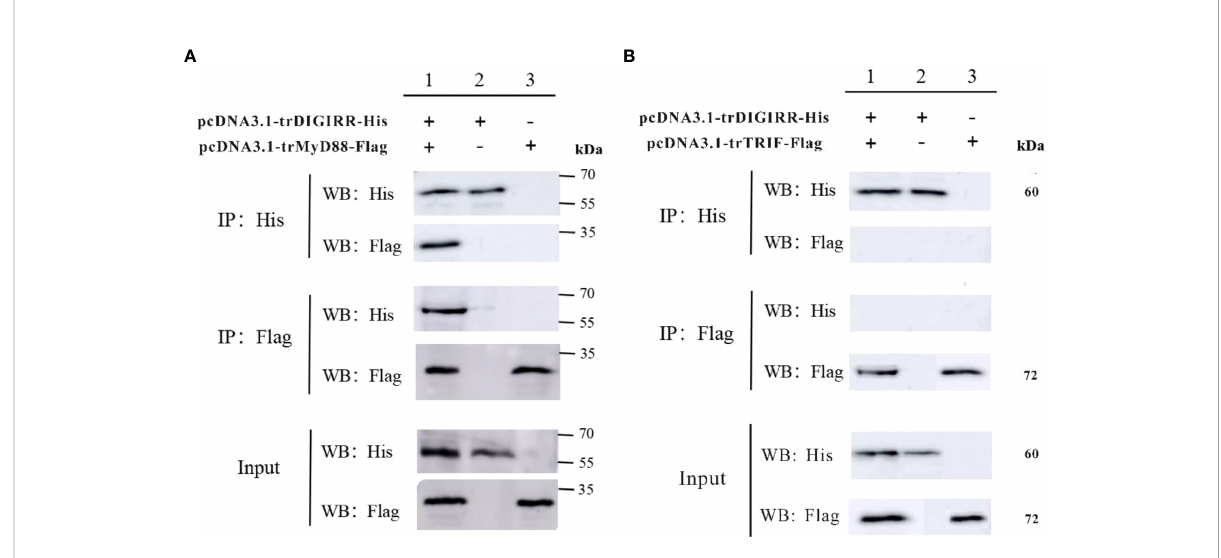
FIGURE 6 Co-immunoprecipitation analysis of the association between trDIGIRR with trMyD88 (A) or trTRIF (B)